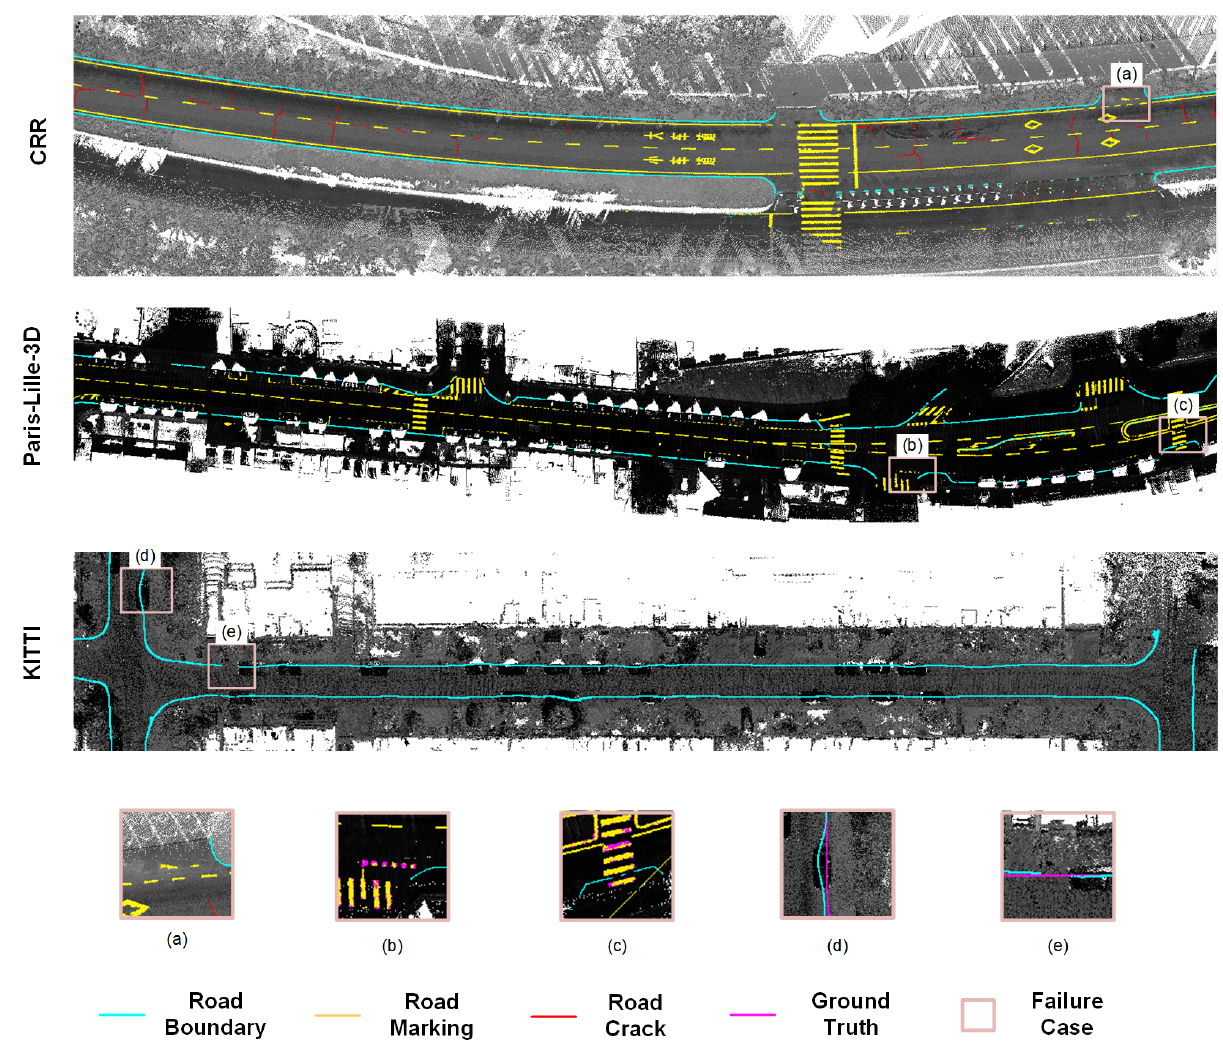
Figure 4. Visualization of the on-road information extraction results on CRR, Paris-Lille-3D and KITTI dataset respectively. The failure cases are shown in (a) to